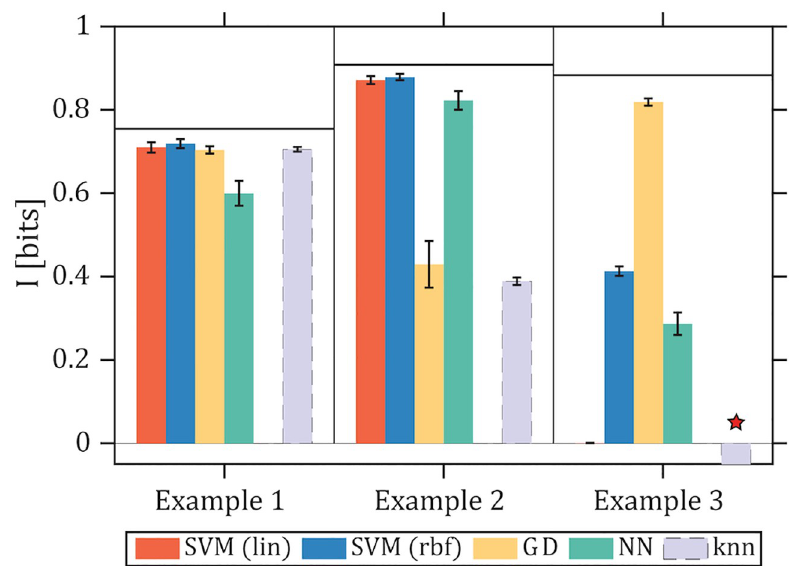
Fig 7. Comparison of decoding-based and knn information estimators. Information estimates for decoding-based (color bars) and knn (gray bar) algorithms (here we set k = 1, for further details on knn estimation, including varying ð ^ U ; U Þ (shown as a horizontal k , see S5 Fig). Note that knn is not a decoding estimator and thus could exceed I MAP black line for each of the three example cases) to approach the exact I exact ( X ; U ). Here we use trajectories discretized over d = 100 time bins, and N = 10 4 trajectory samples per input. The performance of knn can be substantially improved by adding a small amount of gaussian noise to the trajectory samples; its resulting performance as a function of N and d is shown in S5 Fig. Red star denotes the failure of knn on Example 3 where substantially negative information values are returned (exact value not plotted).